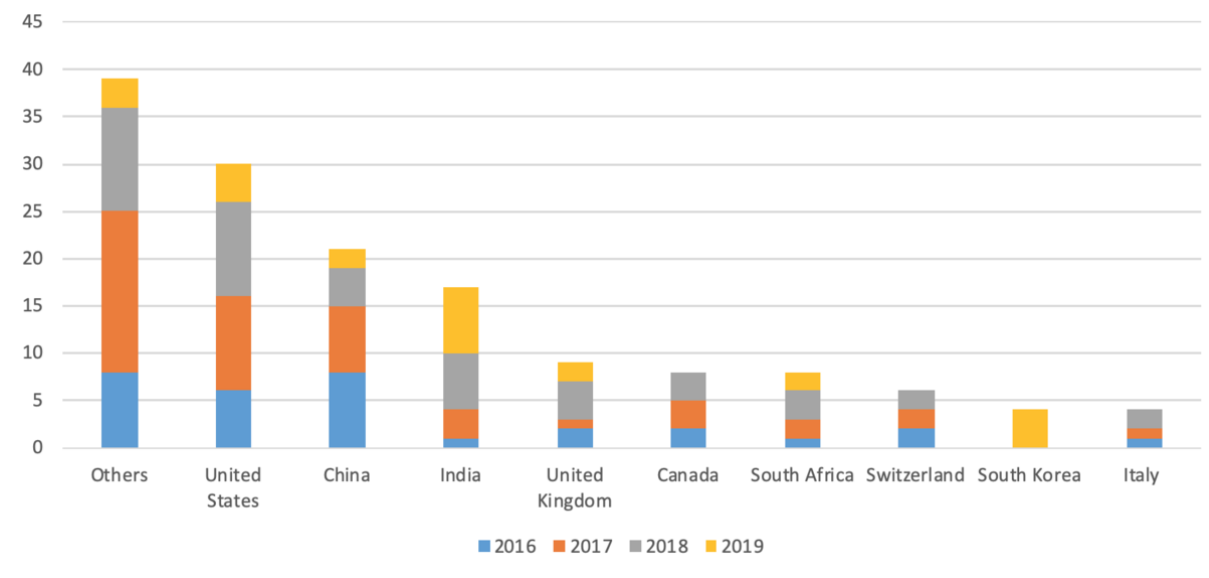
Figure 2. Number of publications by first author’s